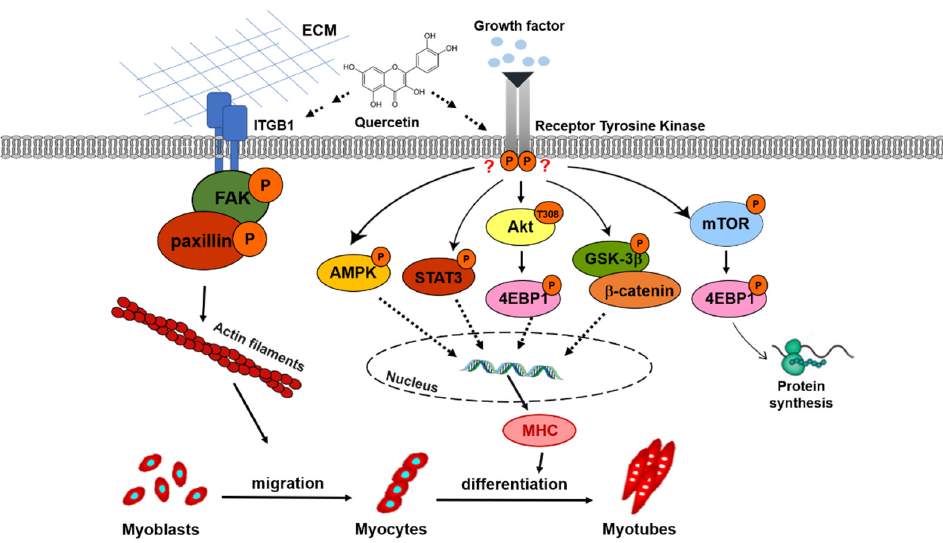
Figure 10. Schematic diagram of quercetin promotion of myoblast migration and myogenic differ- entiation. In this schema, the quercetin-activated ITGB1 receptor recruits focal adhesion proteins via a complex formed by phosphorylated FAK and paxillin, which in turn affects cell migration through interactions between the extracellular matrix and actin filaments. Quercetin induces AMPK activity, regulating skeletal muscle metabolism and increasing consumption of ATP, leading to the regula- tion of MHC expression to myogenic differentiation. Quercetin may indirectly affect downstream signaling involving AKT/4EBP1, GSK-3 β / β -catenin, and STAT3 phosphorylation, increasing the ex- pression of MHC and myogenic differentiation. Furthermore, quercetin also increases protein syn- thesis through mTOR/4EBP1 phosphorylation.